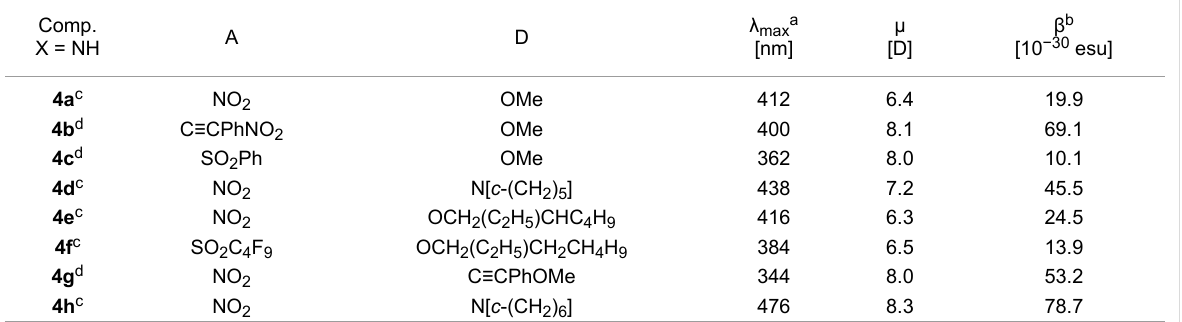
Table 1: Linear ( λ max ) and nonlinear ( β ) optical properties of triarylimidazoles 4a – h (X = NH) [31]. Comp. X = NH